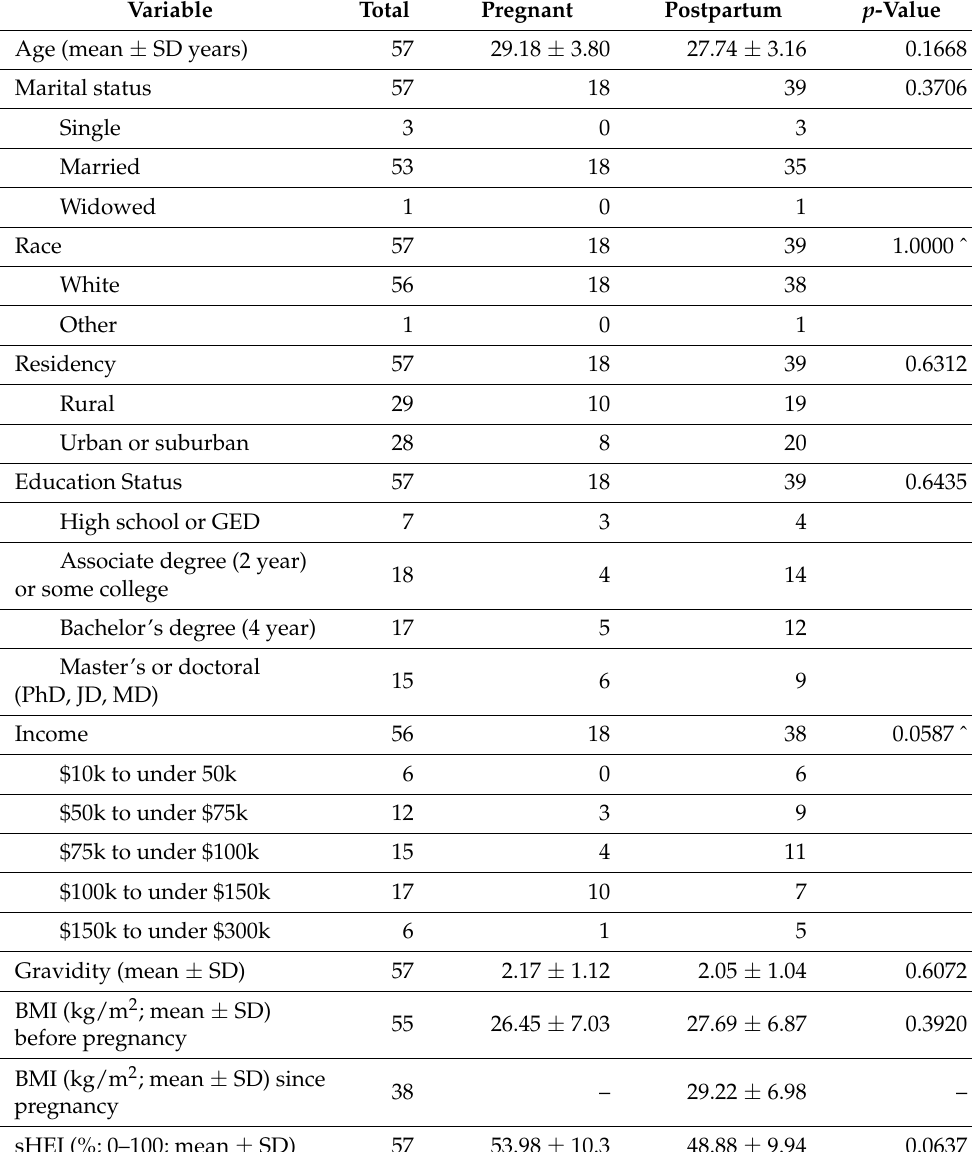
Table 2. Descriptive Characteristics of Study Sample Pregnant and Postpartum